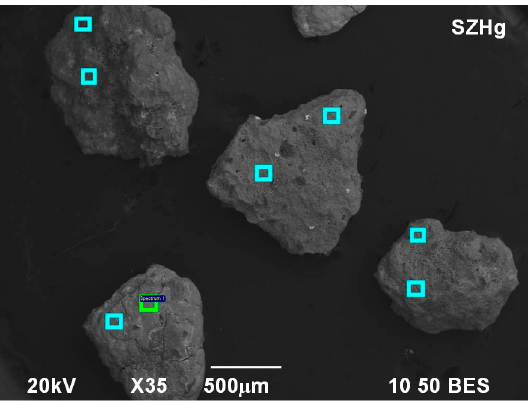
Figure 16. Backscattered electron mode (BSE) images of SZHg with marked eight fields (spectra, Sp) for EDS analysis. Table 8. Semi-quantitative chemical composition (given in wt%) of the eight analyzed fields on the SZHg sample (spectra, Sp; analyzed with EDS).